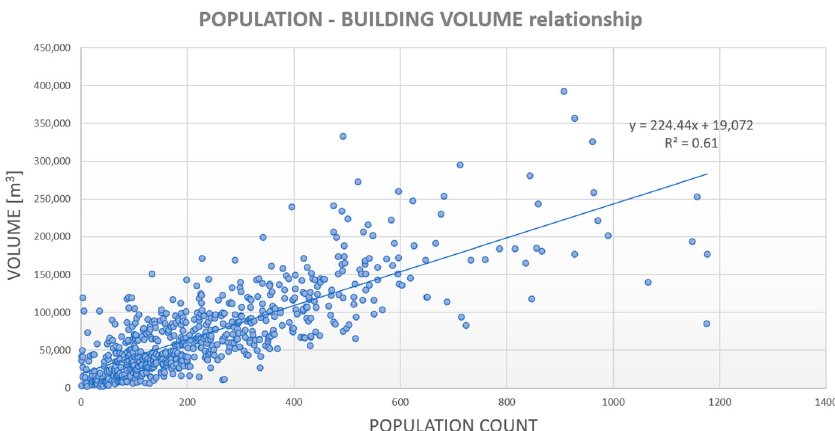
Figure 13. Linear regression of Population against Building Volume.